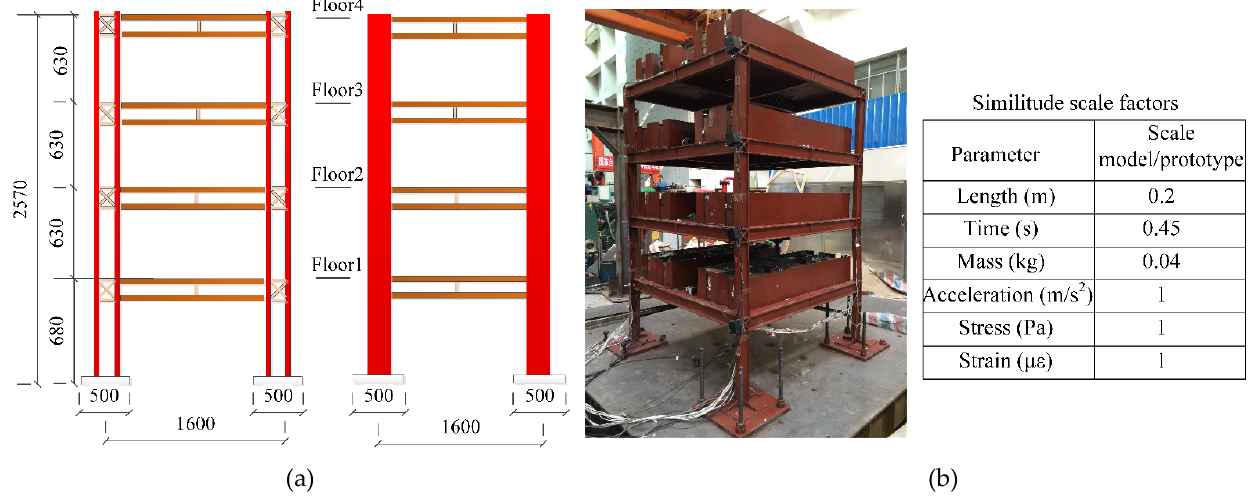
Figure 7. Model of the structure. ( a ) Design of the structure (unit: mm); ( b ) Structure on the shaking table.